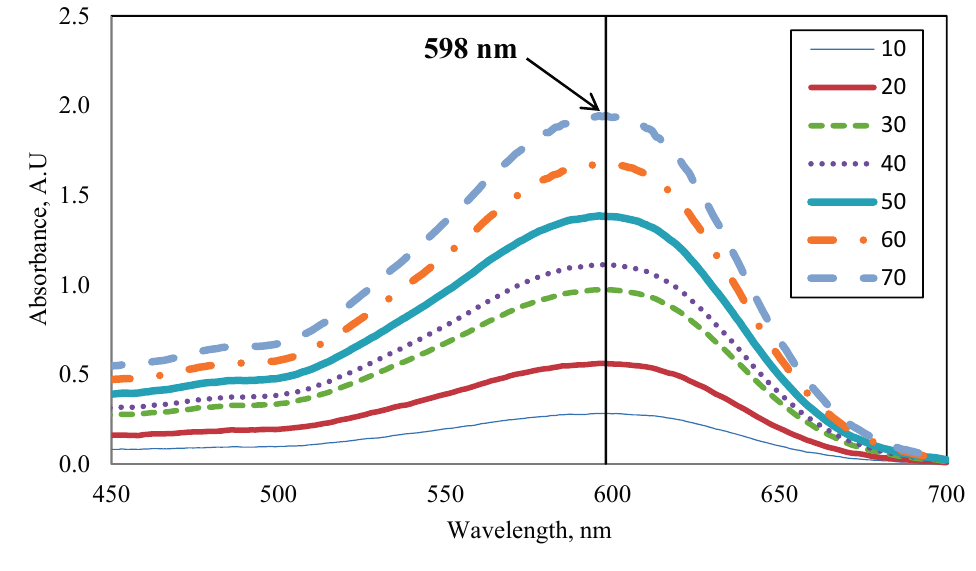
Figure 3. Absorption spectra of the RBB aqueous solution with concentrations ranging from 10 ppm to 70